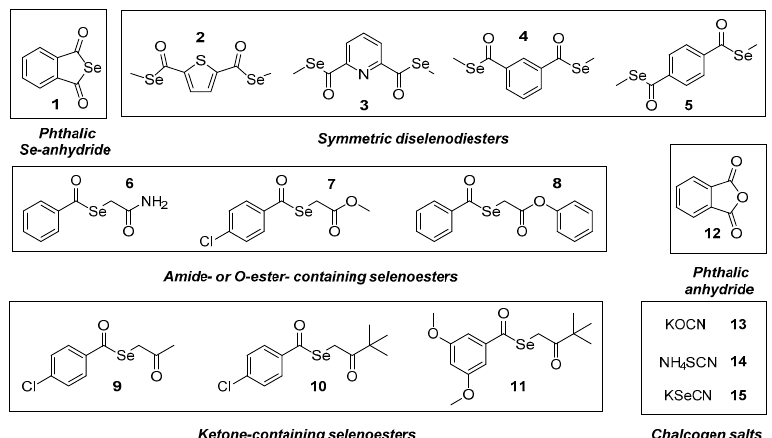
Figure 1. Structure of the tested compounds 1 – 15 .